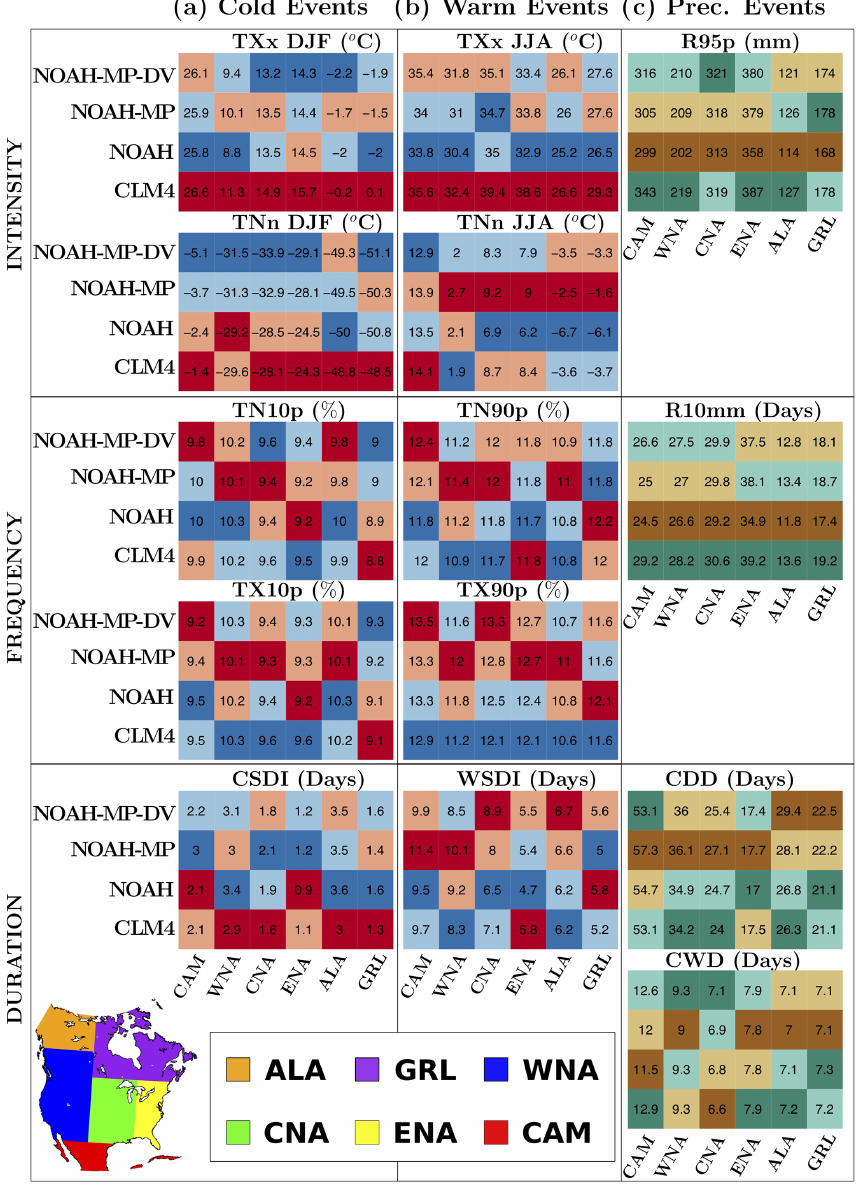
Figure 4. Comparison of the simulated climatologies of temperature and precipitation extreme indices included in Table 2 among the WRF simulations averaging over six land North American regions adapted from Giorgi and Francisco (2000) (Central America, CAM; western North America, WNA; central North America, CNA; eastern North America, ENA; Alaska, ALA; and Greenland, GRL). Colors correspond to the hottest (red) and coldest (blue) index values among the WRF simulations for the representation of cold (a) and warm (b) temperature extremes, and to the driest (brown) and wettest (green) index values for the representation of precipitation extremes (c) over each